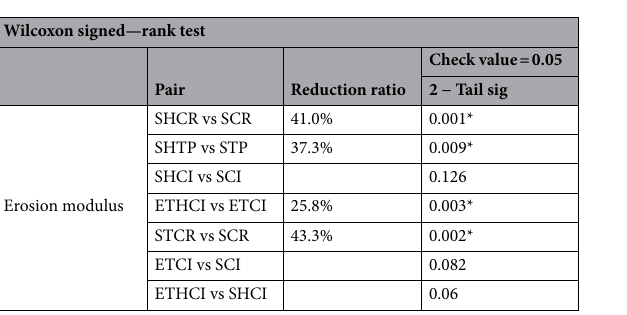
Table 3. The results of the significant differences between erosion modulus of different plots obtained by the Wilcoxon signed rank test (p < 0.05, n = 44). *Represent p <